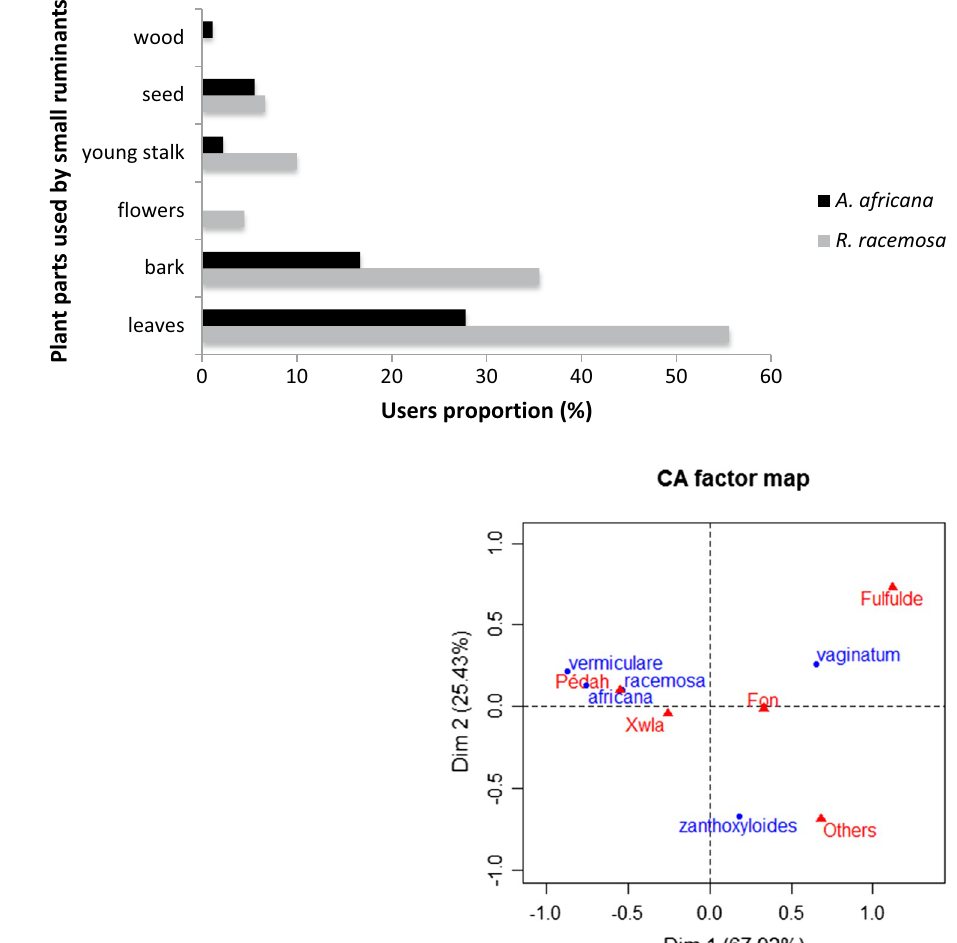
Fig. 2 Uses of plant parts of mangroves true species for small ruminant feeding